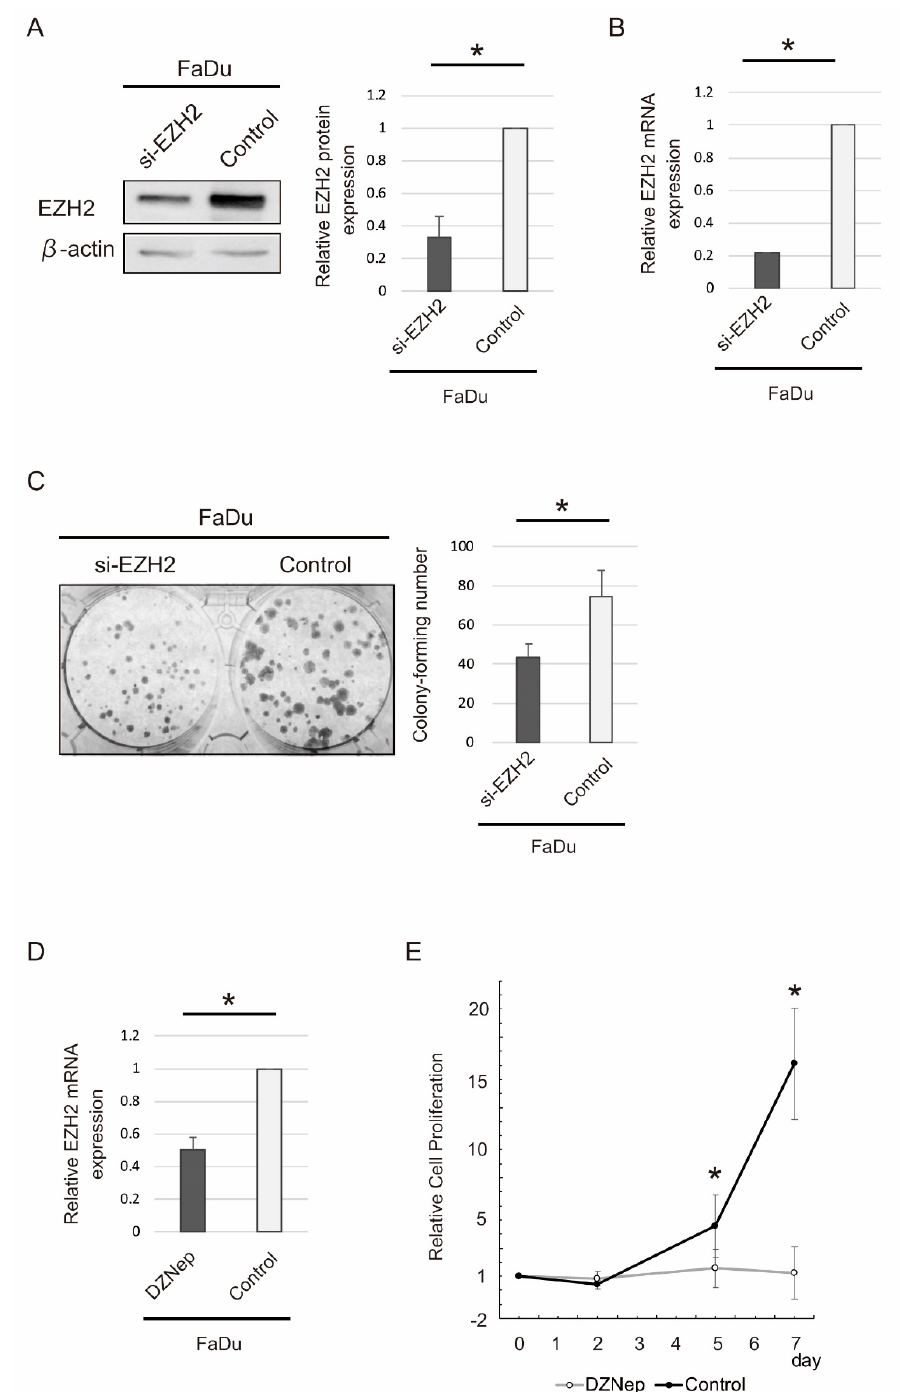
Figure 4. siRNA- and DZNep-mediated EZH2 knockdown inhibited the proliferation of FaDu cells. ( A ) Western blot analysis of EZH2 protein expression after siRNA transfection. ( B ) The chart illustrates the quantification of EZH2 mRNA expression levels via quantitative reverse transcription polymerase chain reaction (qRT-PCR) after siRNA-mediated knockdown of EZH2 mRNA. ( C ) Colony formation upon transfection with EZH2-targeting siRNA or control. ( D ) EZH2 mRNA expression was analyzed via qRT-PCR from FaDu cells treated with DZNep for 48 h. ( E ) Effect of DZNep (10 µ M) on the growth curve. Experiments were performed in duplicate and repeated thrice. The mean ± standard deviation value for each treatment is graphed here. * p <